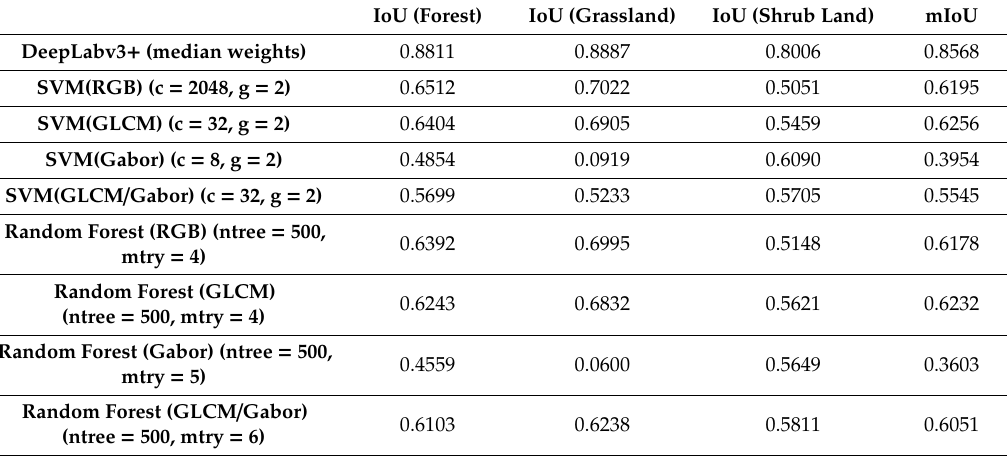
Table 23. IoU and mIoU values for sampled pixels investigation in Slovenia